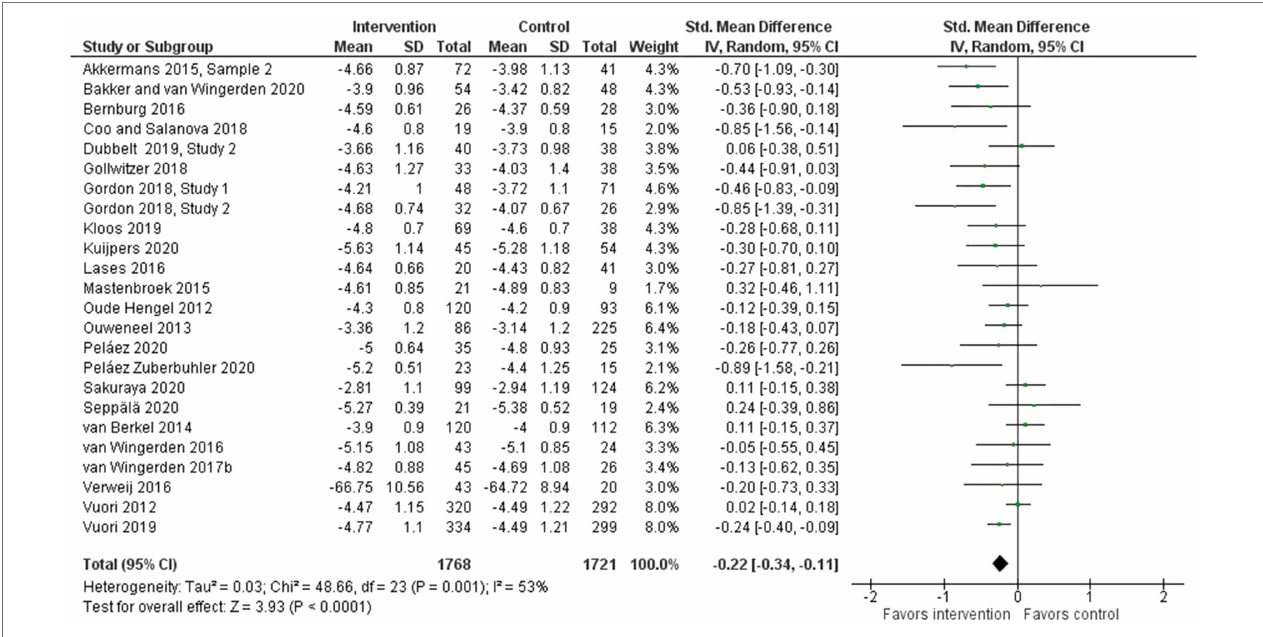
FIGURE 2 | Effect of bottom-up, resource-developing interventions versus no-intervention controls on work